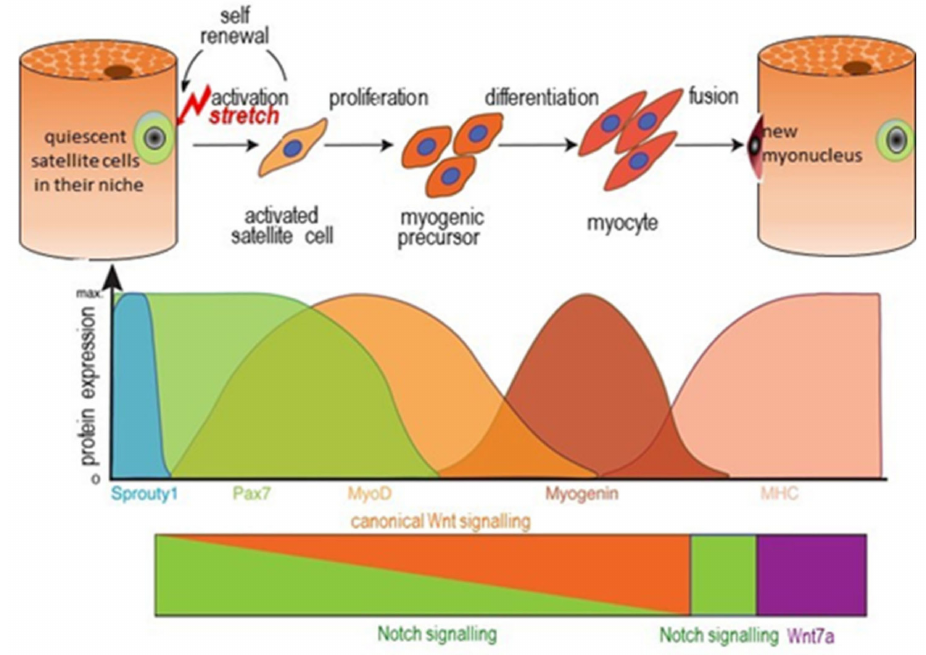
Figure 5. Myogenic lineage progression and expression profile of key myogenic regulators [155]. Top Schematic illustration of the myogenic lineage progression. Satellite cells in their niche are activated by overstretch, start to proliferate, thereby generating myogenic progenitor cells. Upon differentiation, myogenic progenitor cells differentiate into myocytes, which fuse with the myofibre to form new myonuclei enabling myofibre hypertrophy and muscle growth. Middle Expression profile of key modulators of myogenic lineage progression. Sprouty 1 expression maintains a mitotically inactive state similar to quiescence [156]. The transcription factor Pax7 is required for the postnatal maintenance of satellite cells (SCs) and to enable their activation, but is lost after activation and proliferation and it cannot be identified in myonuclei after fusion with the myofibre [157,158]. Of